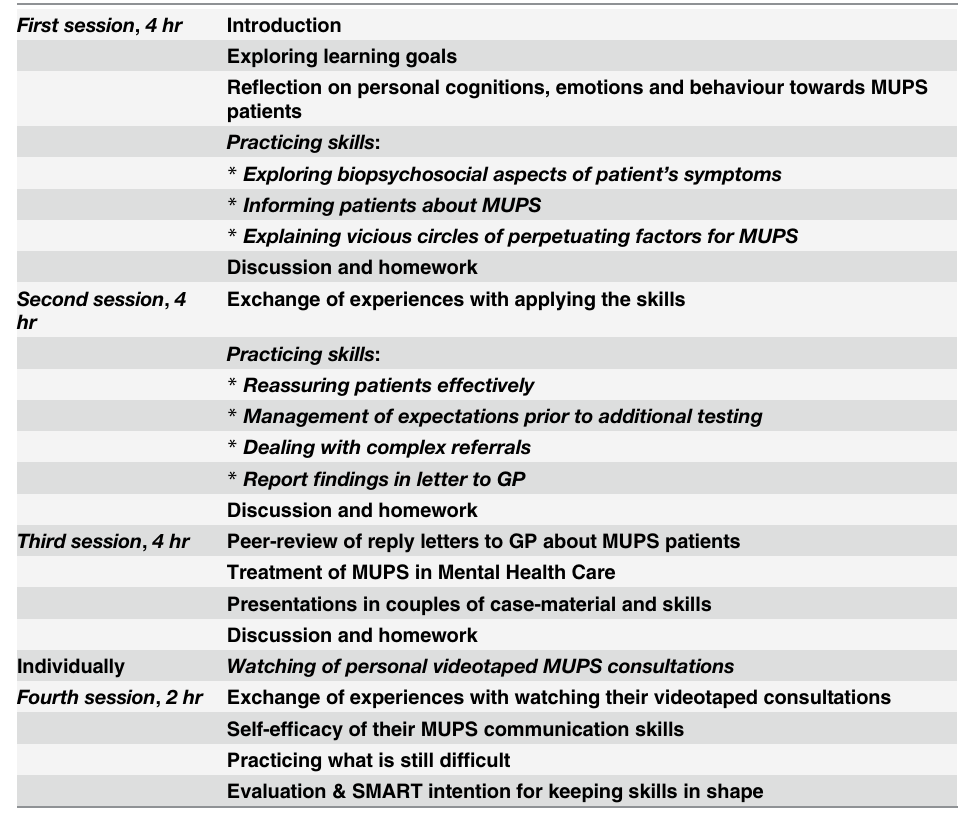
Table 1. MUPS-focused communication training program in specialist